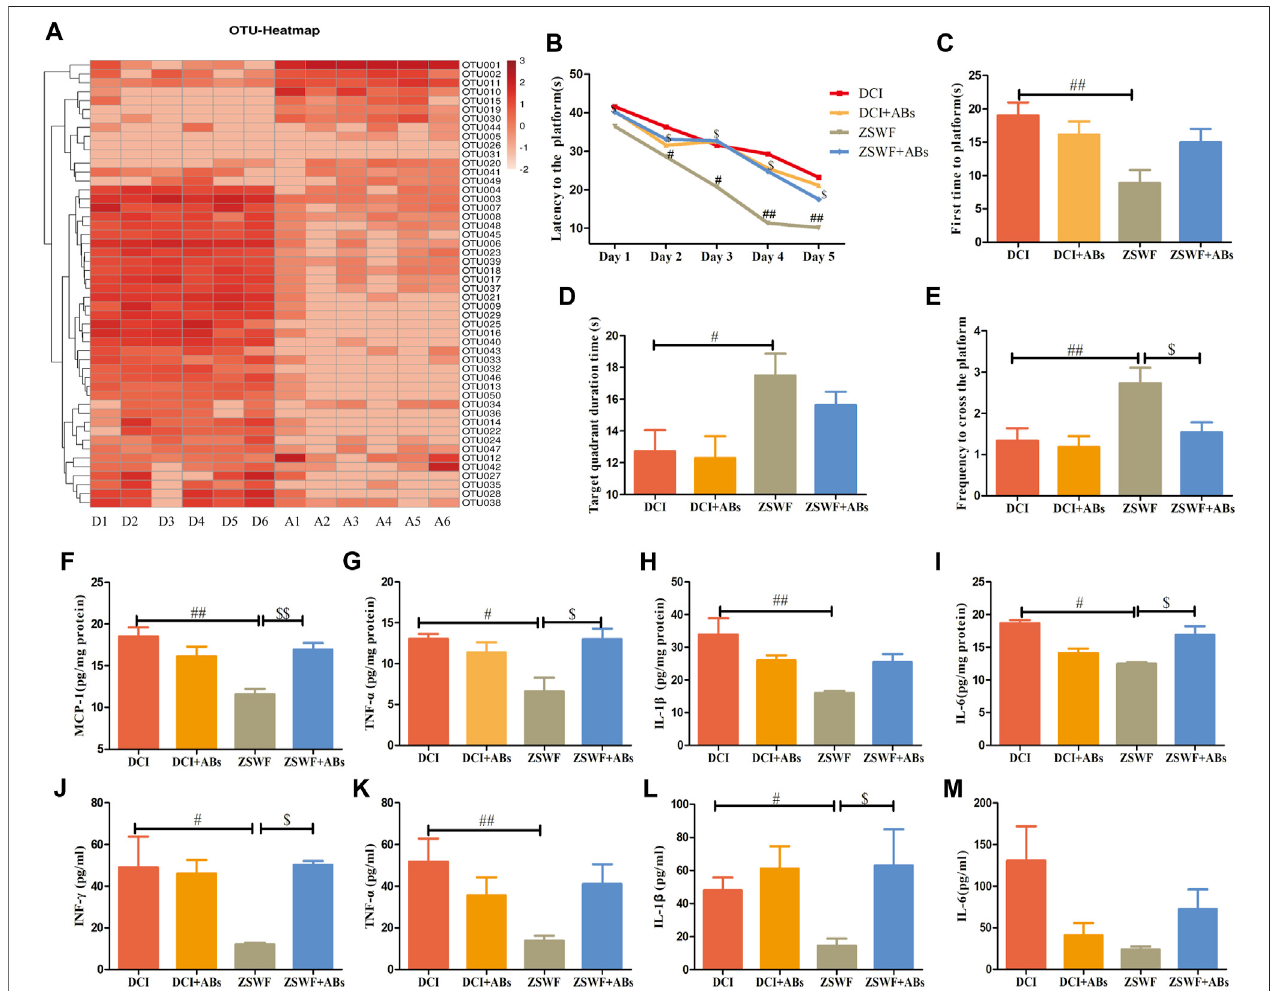
FIGURE5| MicrobiotaablationwithantibioticseliminatedtheeffectsofZSWFonimprovingcognitivefunctionandreducingin fl ammationinDCImice. (A) effectsof antibiotic treatment on relative abundance of intestinal bacteria at genus level in DCI mice. The heat map represents the relative sequence abundance of Top50 OTU of genus level bacteria. The redder color represents more bacteria composition or the higher relative abundance of genus level bacteria. The horizontal axis represents groups, D1 – D6aresixsamplesfromtheDCIgroup,andA1 – A6aresixsamplesfromtheantibioticgroup. (B) escapelatency, (C) timeof fi rstarrivalatplatform, (D) duration in platform quadrant, (E) the frequency of crossing the platform. These data were expressed as mean ± SD ( n = 15). Escape latency data were analyzed by repeated measurement ANOVA, and other data were analyzed by one-way, ## p < 0.01, # p < 0.05 vs. DCI group, $ p < 0.05 vs. ZSWF group. (F) MCP-1 contents in the hippocampus, (G) TNF- α contents in the hippocampus, (H) IL-1 β contents in the hippocampus, (I) IL-6 contents in the hippocampus, (J) INF- γ levels in the serum, (K) TNF- α levels in the serum, (L) IL-1 β levels in the serum, (M) IL-6 levels in the serum. These data were expressed as mean ± SD ( n = 6), one-way ANOVA was used to compare statistical differences between groups, ## p < 0.01, # p < 0.05 vs. DCI group, $$ p < 0.01, $ p < 0.05 vs. ZSWF group.